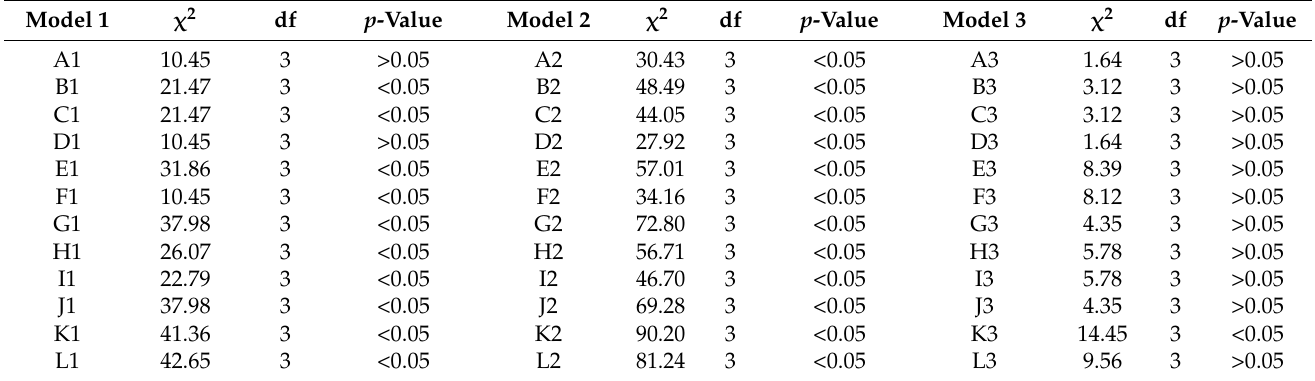
Table 3. Goodness-of-fit chi-square tests, probability level corrected with Sidak